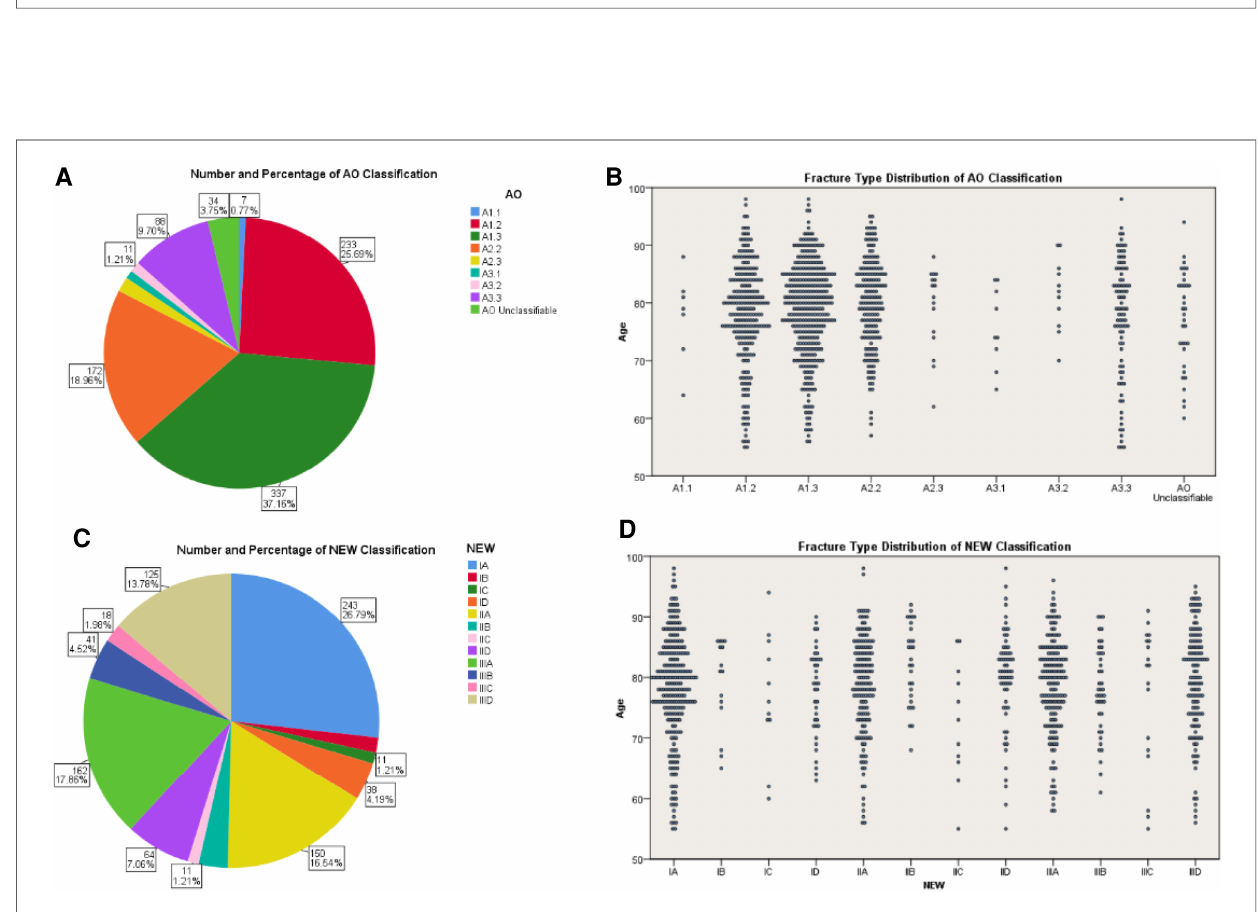
FIGURE 3 Patients and coverage. ( A ) Age distribution of the study population ( n =907, mean age=78.66 years, males=356, females=551). ( B ) Distribution of fractures unclassi fi able in AO classi fi cation (IB=8, IC=10, ID=13, IIC=1, IID=1, IIID=1).